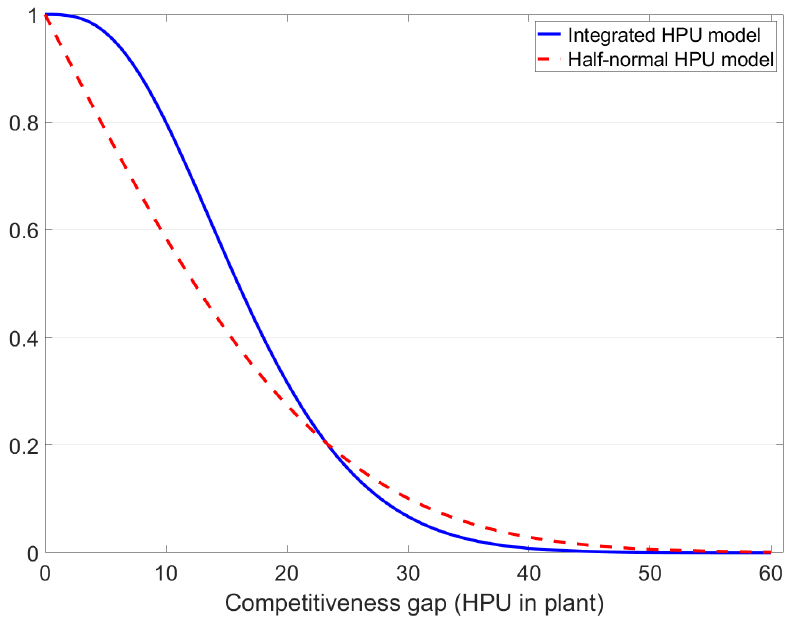
Figure 8. Cumulative distribution functions of inefficiency for integrated model and half- normal model.